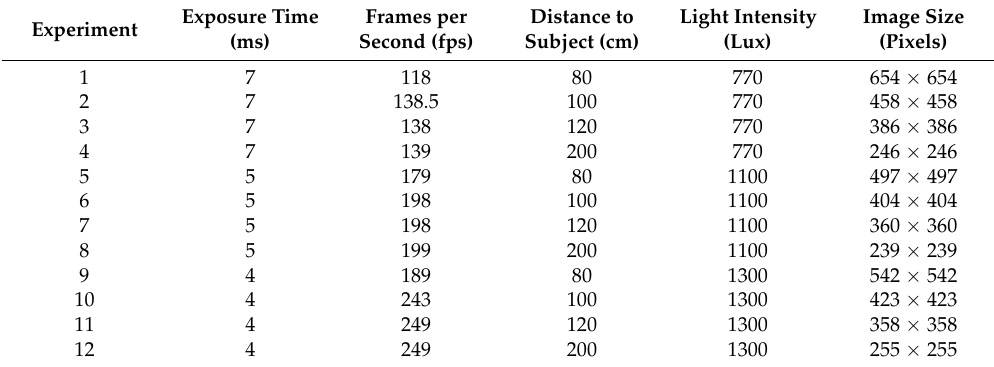
Table 6. ME detection performance—comparison with state of the art.